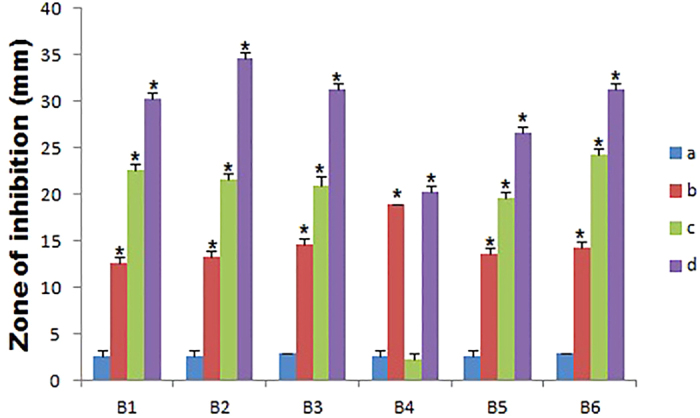
The Column chart showing the ZOI measurement of SNPs, topical antibiotic and combinations against P. aeruginosa.B1: Cefazolin; B2: Mupirocin; B3: Gentamycin; B4: Neomycin; B5: Tetracycline; B6: Vancomycin. a: Control; b: SNP; c: Topical antibiotic; d: SNP + Topical antibiotic. Values are expressed as means (n = 3), and error bars represent standard deviations. Asterisks (*) indicate a statistical significant difference (P < 0.05) between the control and the treatments.